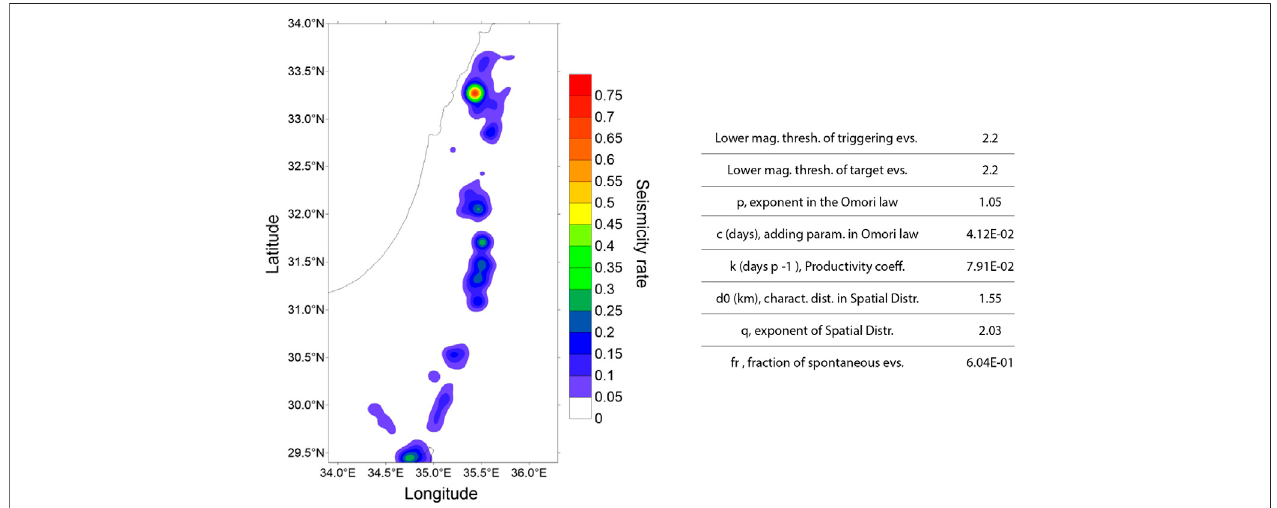
FIGURE 3 | Smoothed seismicity of the Israeli seismic catalog in the learning period January 01, 1983 – December 31, 2015. The correlation distance is 9 km. The color scale represents the number of earthquakes with M ≥ 2.2 and depth ≤ 30 km, in a 1 km 2 area, over the whole time period spanned by the catalog. The list of the model parameters and their corresponding values are shown on the